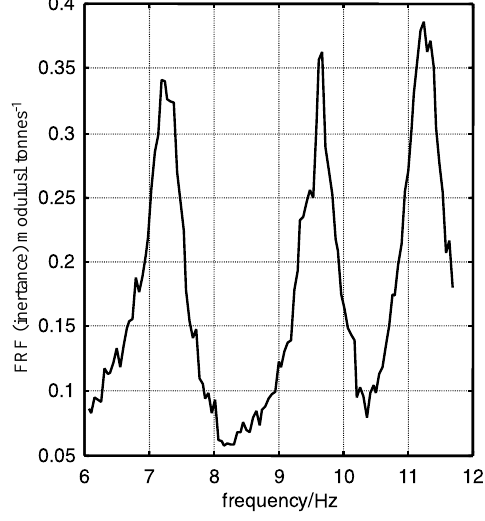
Fig. 9. FRF for bare composite